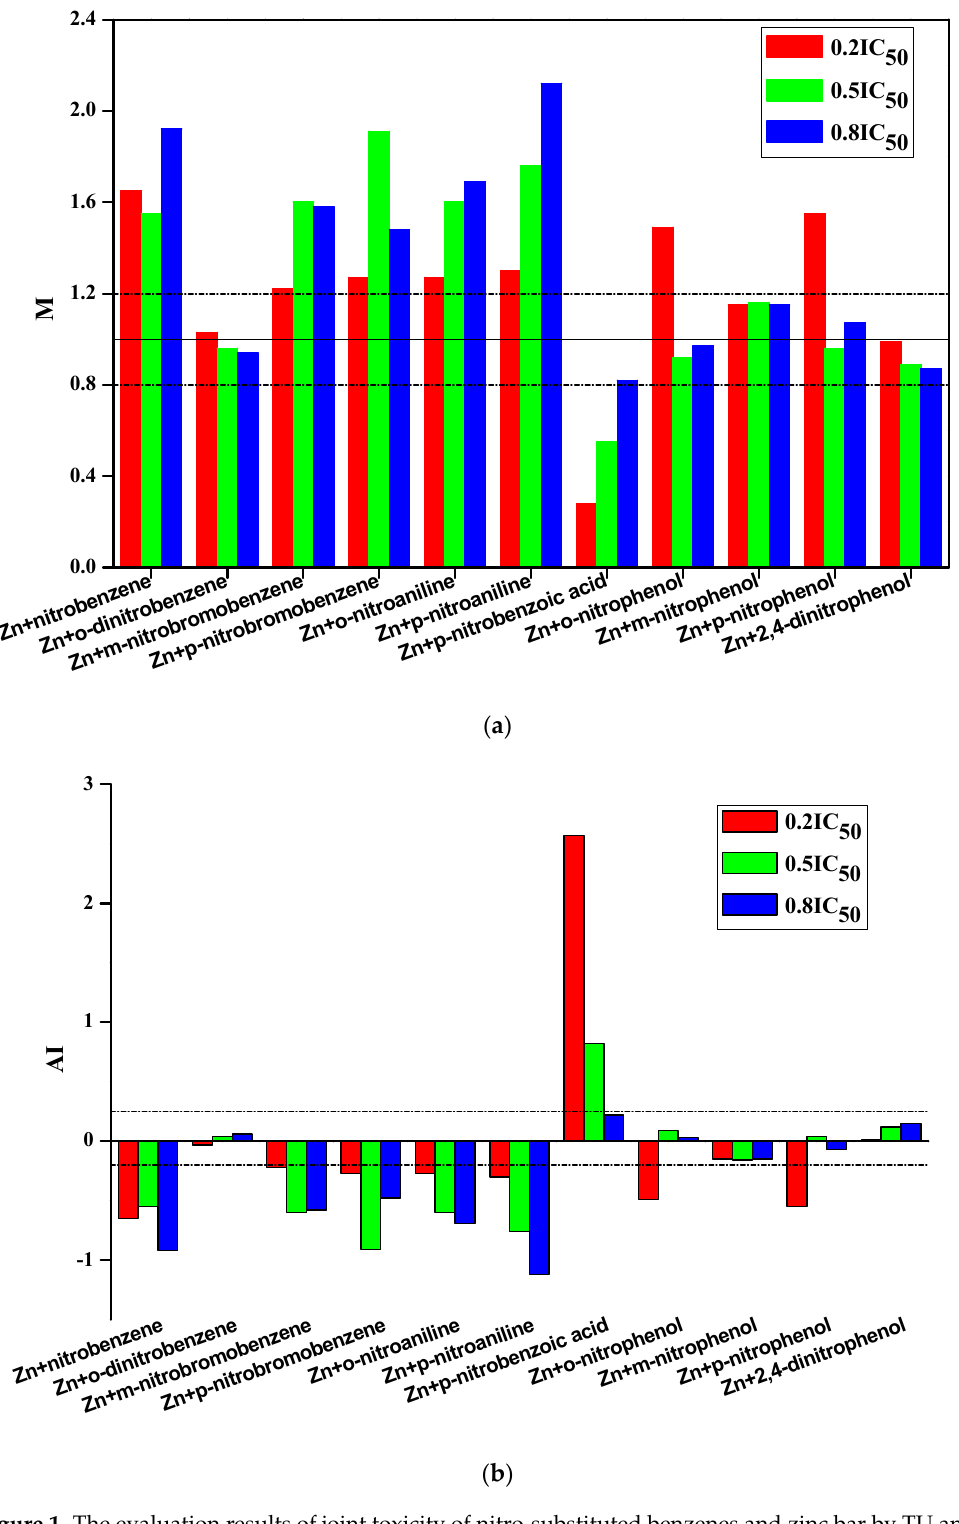
Figure 1. The evaluation results of joint toxicity of nitro-substituted benzenes and zinc bar by TU and AI methods (( a ) values of M; ( b ) values of AI).